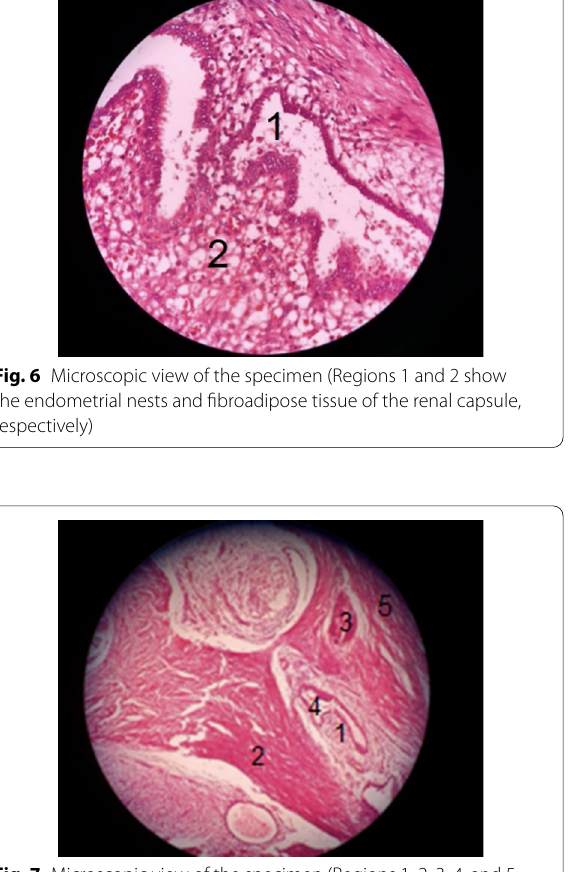
Fig. 7 Microscopic view of the specimen (Regions 1, 2, 3, 4, and 5 show fibroadipose tissue, stroma, hemorrhage, endometrial nest, and the renal capsule,